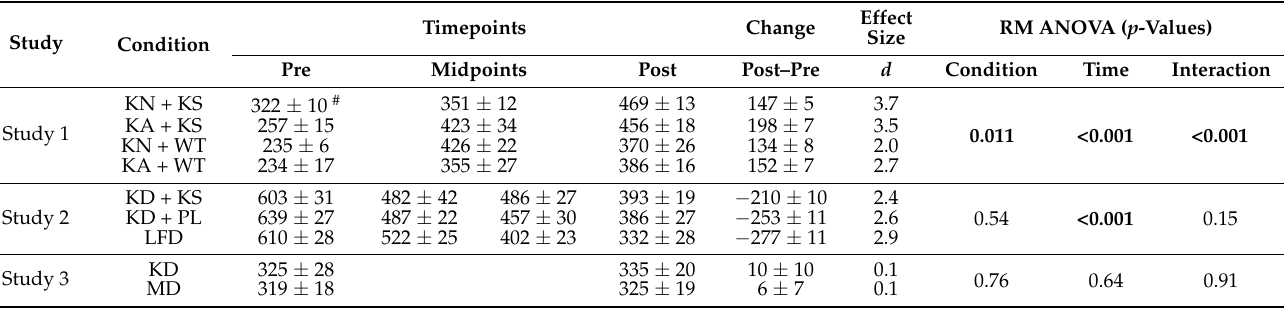
Table 2. BDNF Main Effects and